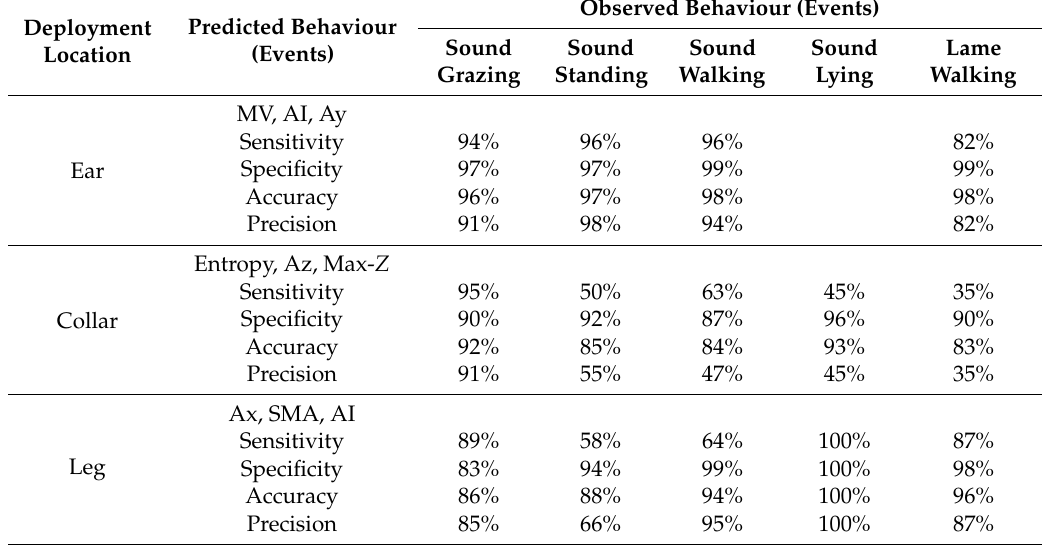
Table 7. Performance statistics of the leave-one-out cross validation for the QDA classification model to discriminate between the five mutually exclusive behaviours from Analysis